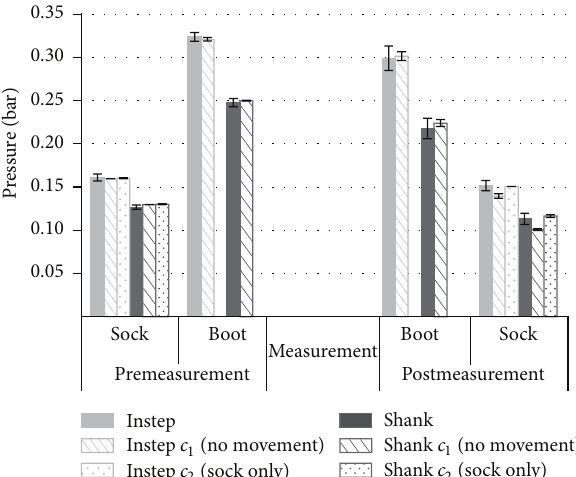
Figure 3: Pressure prior to mounting the boot (premeasurement, sock), after lacing the boot (premeasurement, boot), after the measurement but still with the laced boots (postmeasurement, boot),andafterremovaloftheboot(postmeasurement,sock)forthe three different measurement protocols (normal; 𝑐 1 (no movement); 𝑐 2 (sock only)) measured using both air